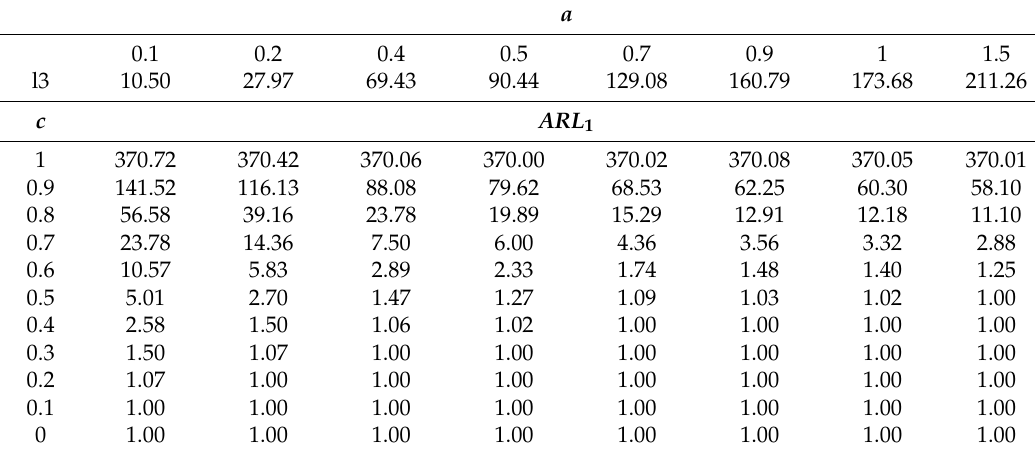
Table 5. The values of ARLs when r 0 = 370, β = 1.5, and µ 0 = 50.